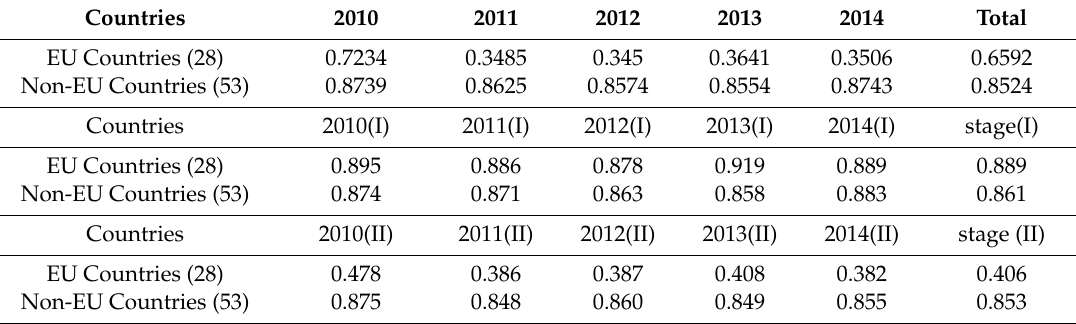
Table 8. Average overall TGRs of EU and non-EU countries from 2010 to 2014.